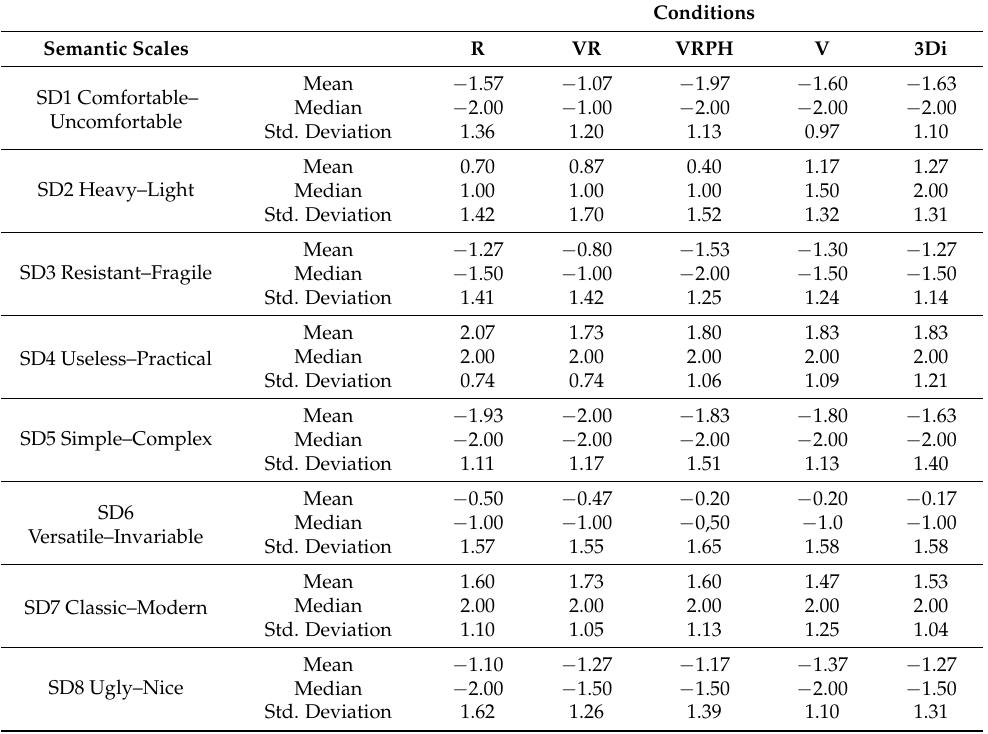
Table 2. Descriptive statistics for the semantic